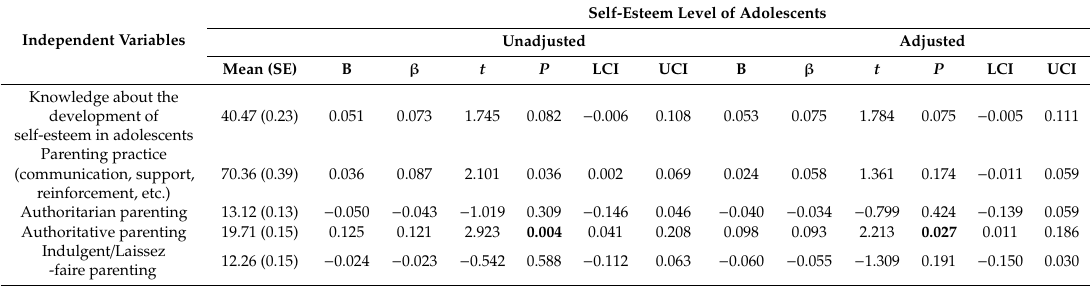
Self-Esteem Level of Adolescents Unadjusted Adjusted